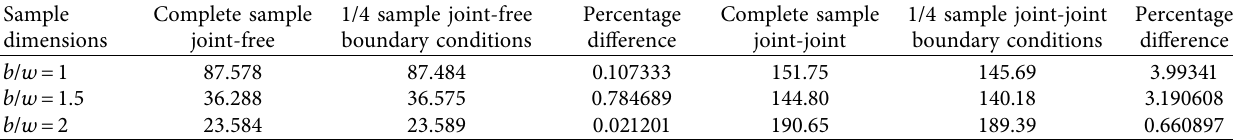
Table 13: Comparing obtained results from 1/4 modeling and complete modeling.